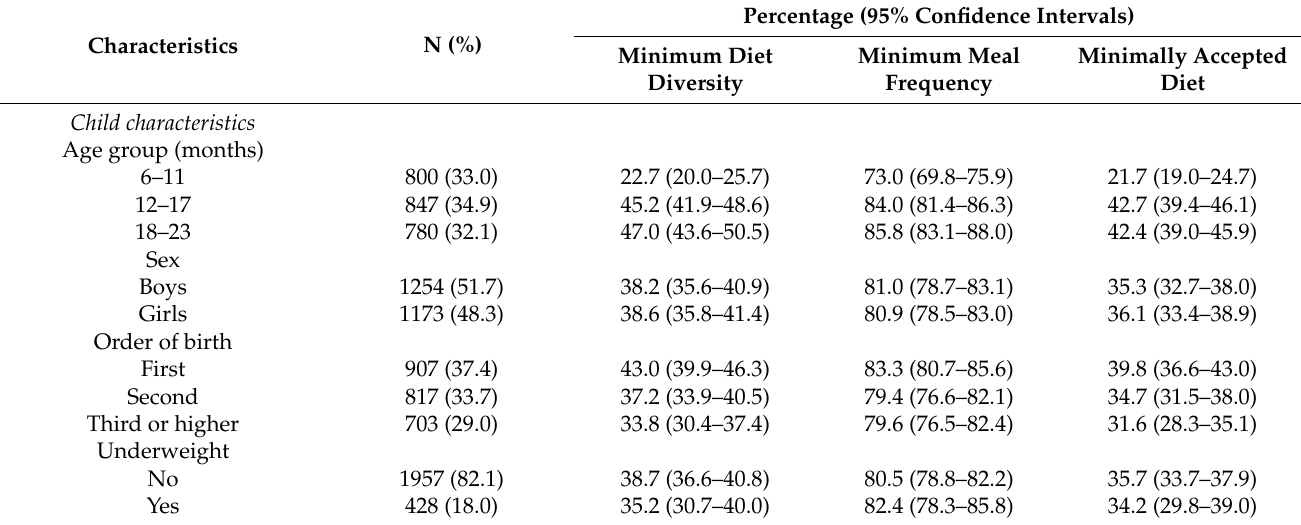
Table 1. Weighted percentage of minimum diet diversity, minimum diet frequency and